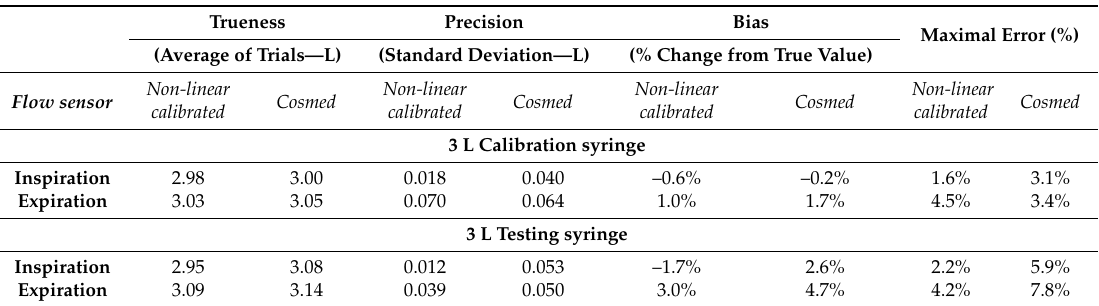
Table 1. Performance of the calibrated flow sensor with two 3 L syringes (calibration syringe and testing syringe) compared to a commercial spirometer (Cosmed). Values in both flow sensors are presented in ambient temperature, pressure, and humidity